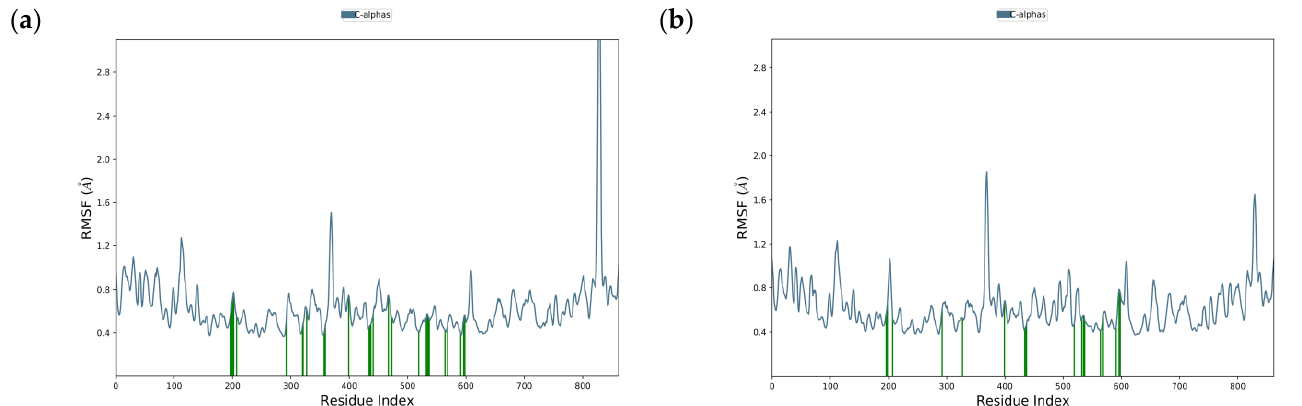
Figure 4. Root mean square fluctuation (RMSF) plotting (blue line) of: ( a ) acarbose and ( b ) naringenin, with specific residues of α -glucosidase (green line) during 20 ns simulation.